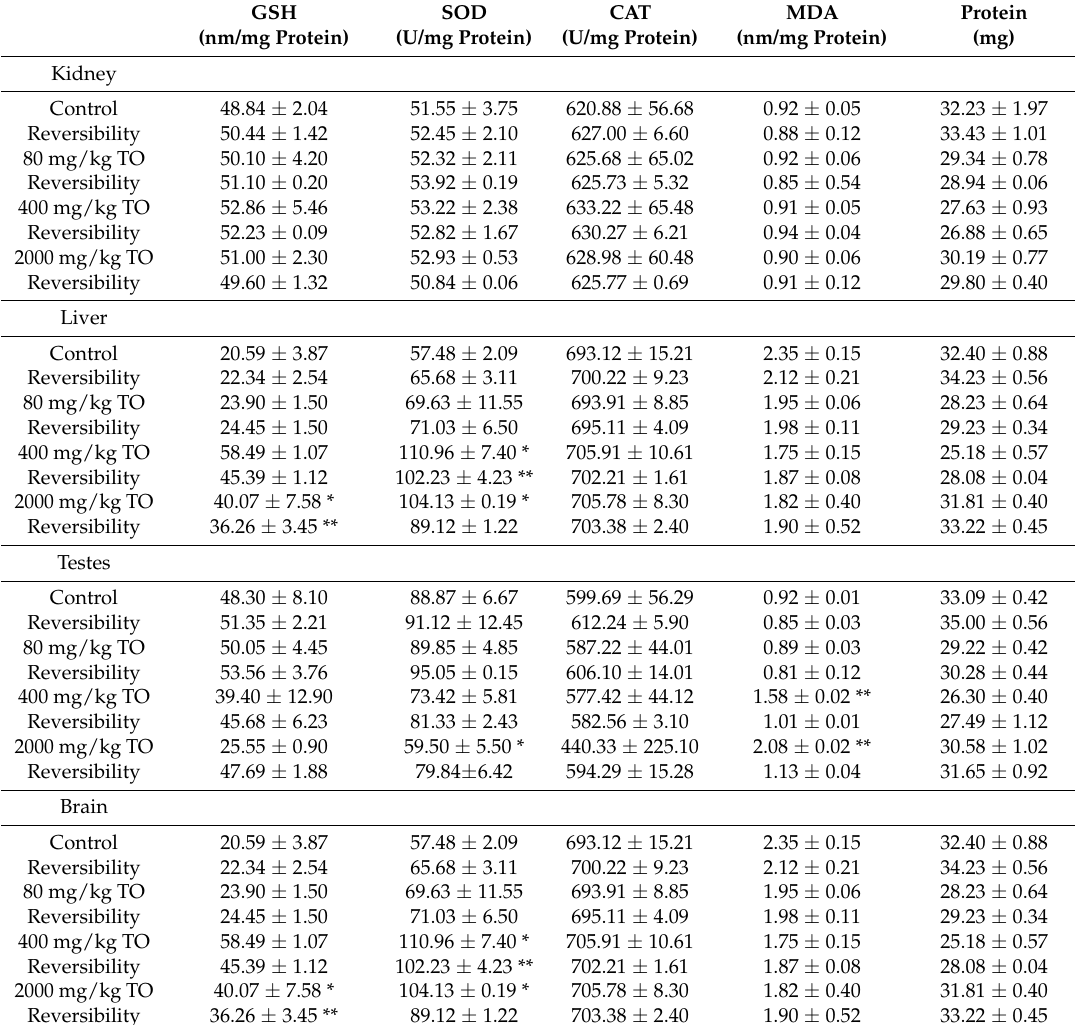
Table 6. Effect of T. occidentalis on kidney, liver, testes and brain antioxidant indices in